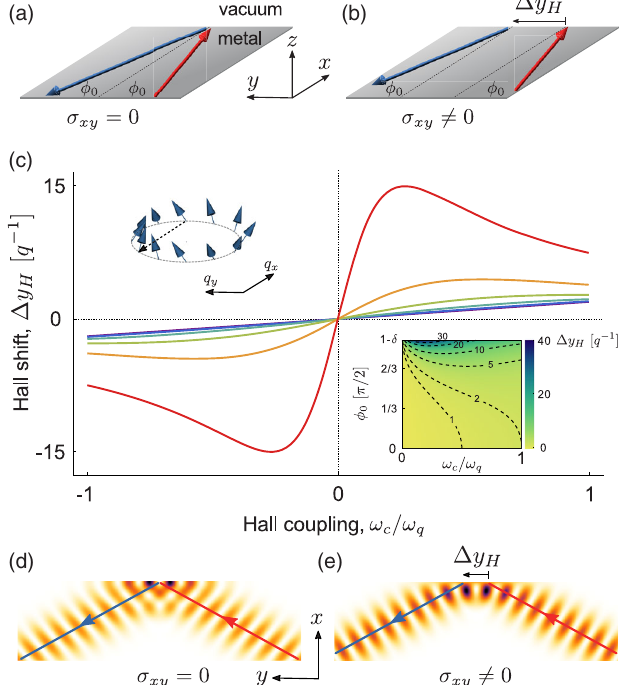
FIG. 3. Plasmon Hall shift. (a),(b) Schematic of plasmon Hall shift between the incident and reflected wave packets with incident angle ϕ 0 . The Hall shift Δ y is nonzero when H σ ≠ 0 . (c) Plasmon Hall shift for 2D magnetoplasmons (in xy units of inverse wave vector q − 1 ) from Eq. (16) at various incident = ω angles ϕ 0 can be tuned by the Hall coupling η ¼ ω . Lines c q 0 ) to red (farthest away from purple (closest to the line Δ y H ¼ 0 ) correspond to incident angles ϕ from the line Δ y H ¼ n ¼ ð π = 2 Þð n= 6 Þ with n integers in the range n ∈ f 0 ; … ; 5 g . The upper inset displays the pseuodospinor orientation on a bulk plasmon isofrequency contour highlighting the different orientations between incident and reflected waves. Lower inset: Contour plot of Hall shift as a function of Hall coupling and ϕ 0 . We have used δ ¼ π = 20 . (d),(e) Numerically computed electric field intensity ½ Re E i ð r Þ þ Re E r ð r Þ(cid:2) 2 from Eq. (13), without and with magnetic 1 limit), for an incident wave with a Gaussian field (at η q ¼ distribution and fixed energy. The width of the wave is π =q and the incident angle is π = 3 , with a Hall shift 4 =q . Red and blue lines are beam trajectories obtained from Eq.